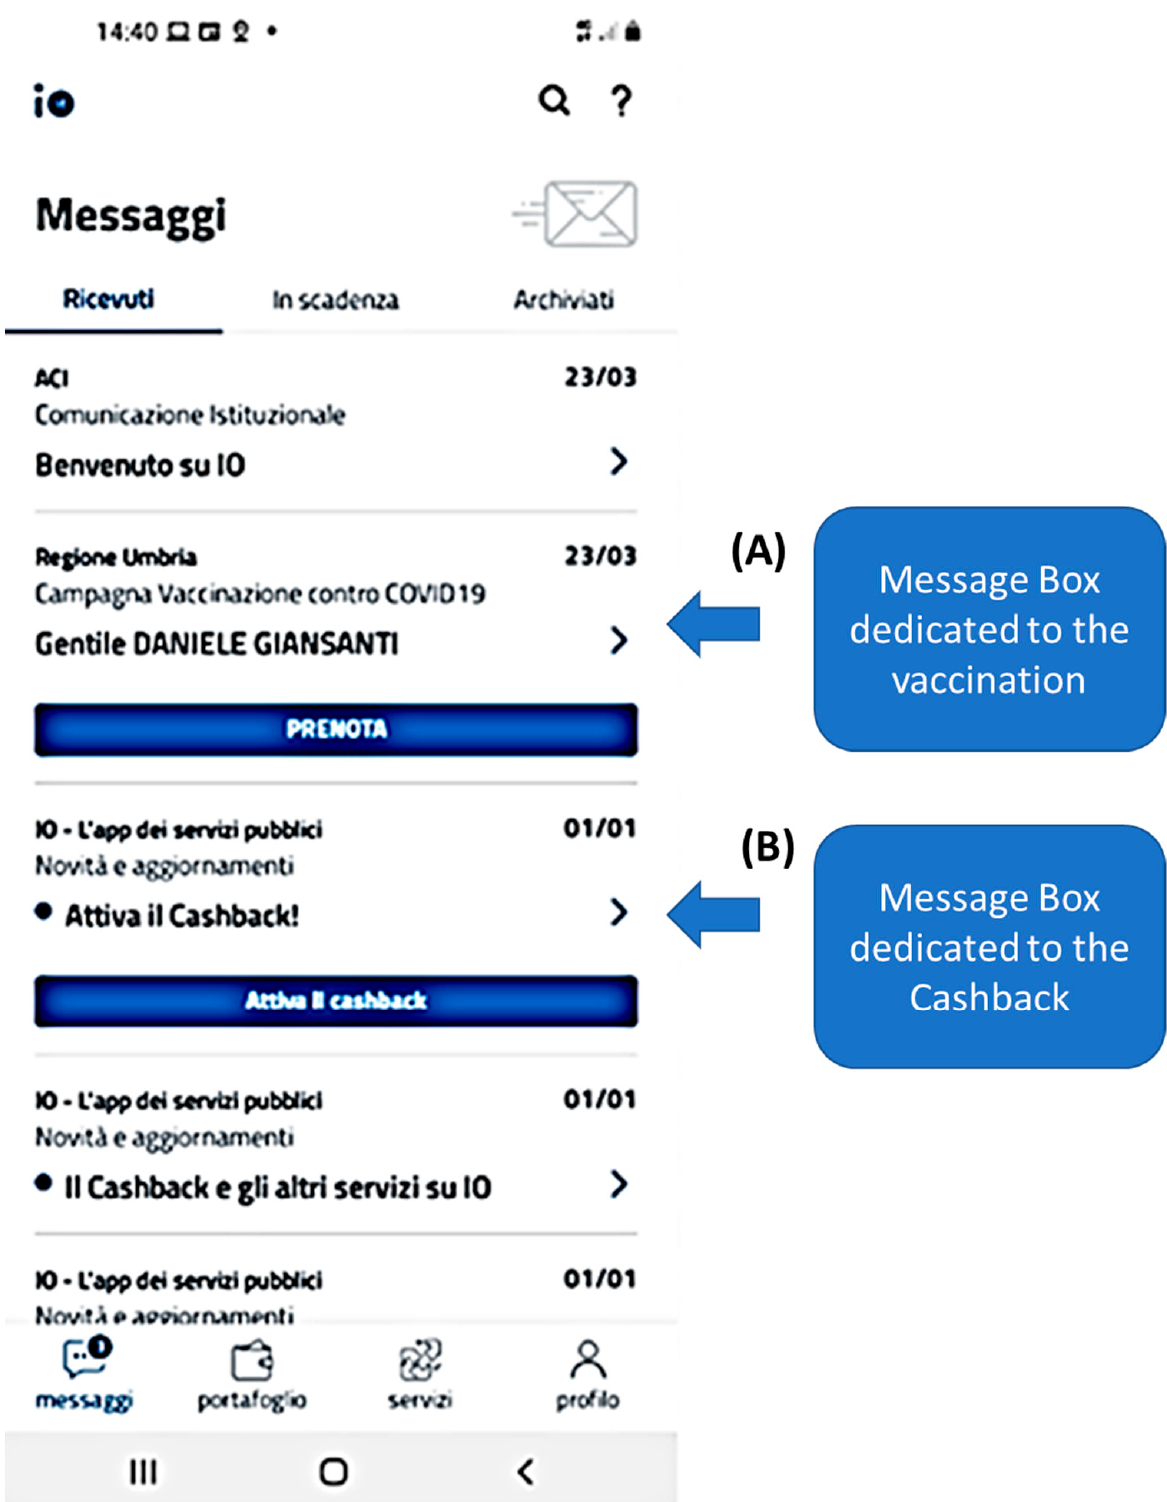
Figure 2. The message box dedicated: ( A ) to the vaccination program ( B ) the Cashback.